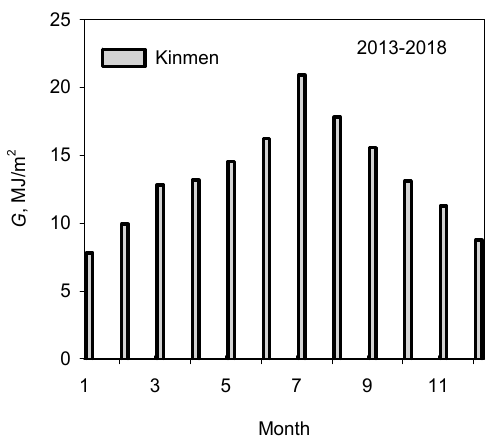
Figure 1. Average monthly global horizontal solar radiation in Kinmen County for solar thermal application .